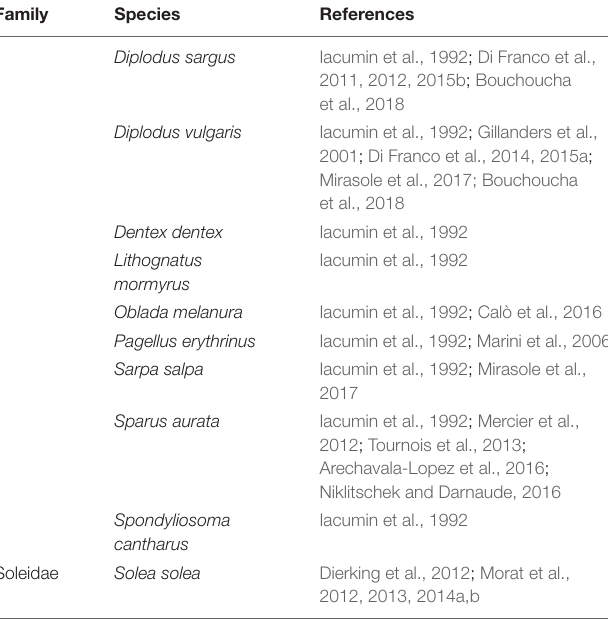
TABLE 1 | List of Mediterranean fish species targeted in the otolith microchemistry